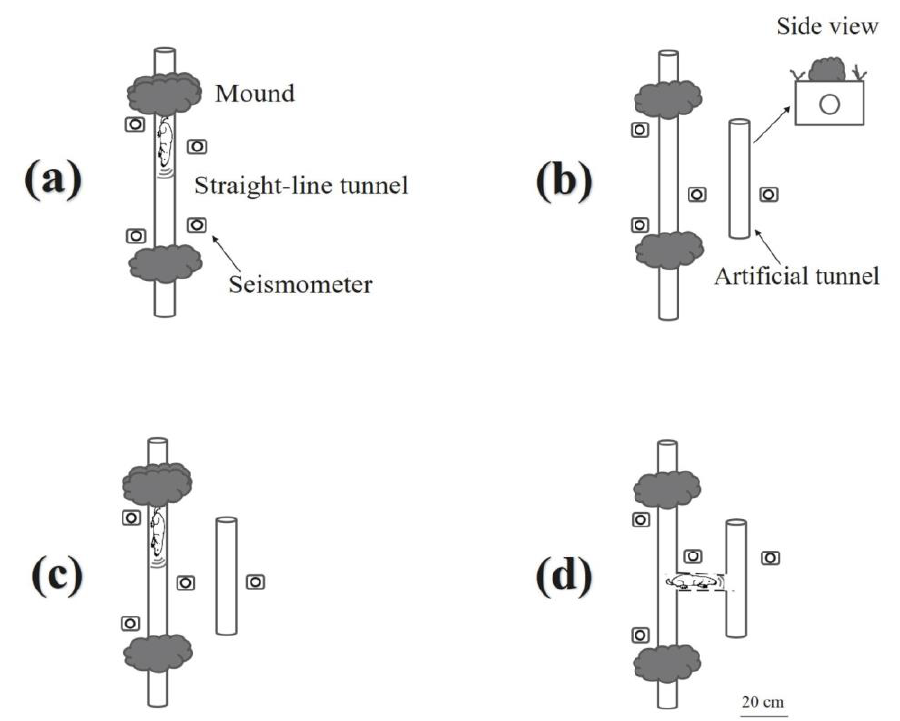
Figure 2. Schematic drawings of the stages of the occupation experiment with plateau zokors (plan view): ( a ) seismic signals near original tunnels; ( b ) artificial tunnels based on native plateau zokor activity; ( c , d ) acquisition of seismic signals during occupation of artificial tunnel.